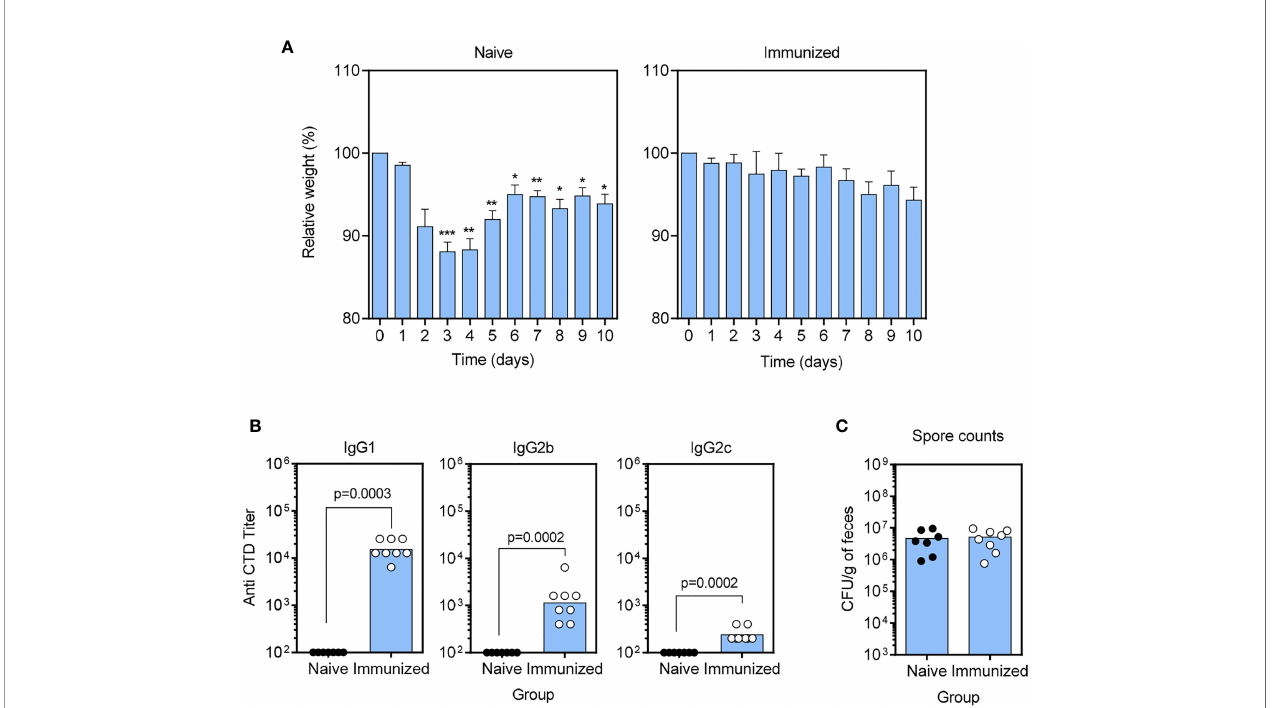
FIGURE 2 | Inclusion of the a -GC analog 7DW8-5 in the CTD/Alum vaccine does not confer changes to IgG subclass or protection beyond that provided by a -GC. (A) B6 mice were immunized s.c. with PBS vehicle (naïve) a single dose of the CTD/Alum plus 7DW8-5 vaccine before antibiotic treatment and C. dif fi cile spore challenge. Weights were then monitored daily. Graphs show mean ± SEM percentages of pre-infection weights (Naïve, n=7, Immunized, n=8). A Two-way repeated measures ANOVA with Dunnett ’ s multiple comparisons test was used to detect statistically signi fi cant differences in weight. (*P < 0.05; **P < 0.01; ***P < 0.001). (B) Anti-CTD IgG1 (left), IgG2b (middle), and IgG2c (right) were detected by ELISA. Endpoint titers are shown, and each data point represents an individual mouse. Statistical signi fi cance was detected by 2-tailed Mann-Whitney U test. (C) C. dif fi cile spore counts in day 3 fecal pellets were determined as described in Materials and Methods